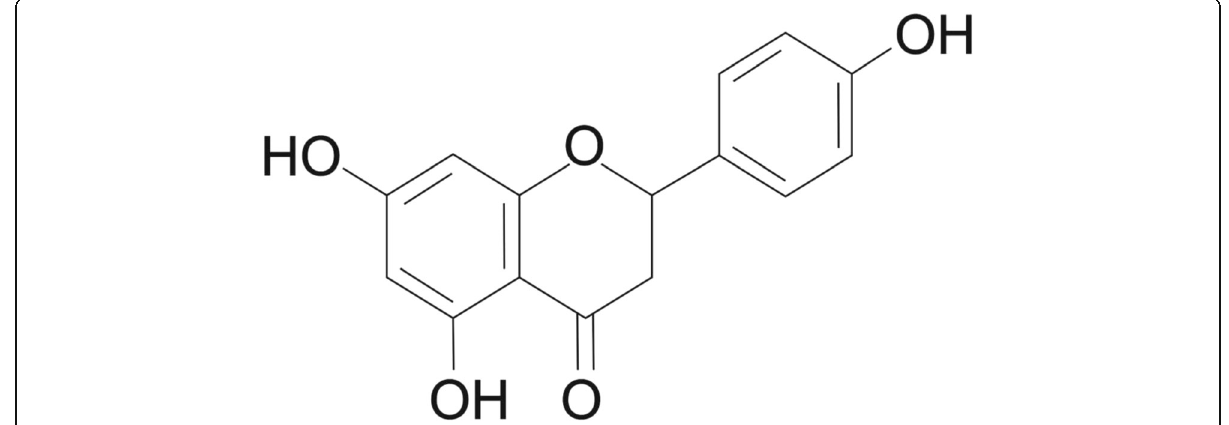
Fig. 1 Chemical structure of